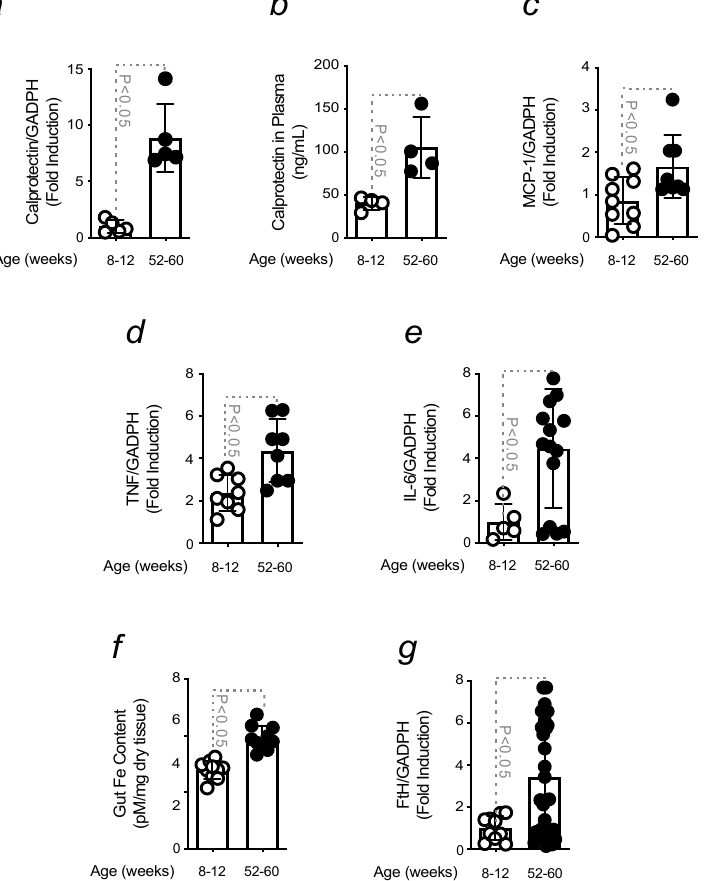
Figure 3. Increased inflammation and iron content in aged mice. ( a ) Calprotectin mRNA expression, quantified by qRT-PCR, in the gut of young vs. old mice, and ( b ) the results were confirmed by ELISA. mRNA expression of ( c ) MCP-1, ( d ) TNF, and ( e ) IL-6 as in ( a ). ( f ) Intracellular Fe content measured in the gut of mice as in ( a ). ( g ) mRNA expression of FtH as in ( a ). The results were normalized to Arbp0, used as housekeeping gene, and expressed as mean ± SD ( n = 10–15 mice per group). The parametric Student’s t -test was applied to define statistical